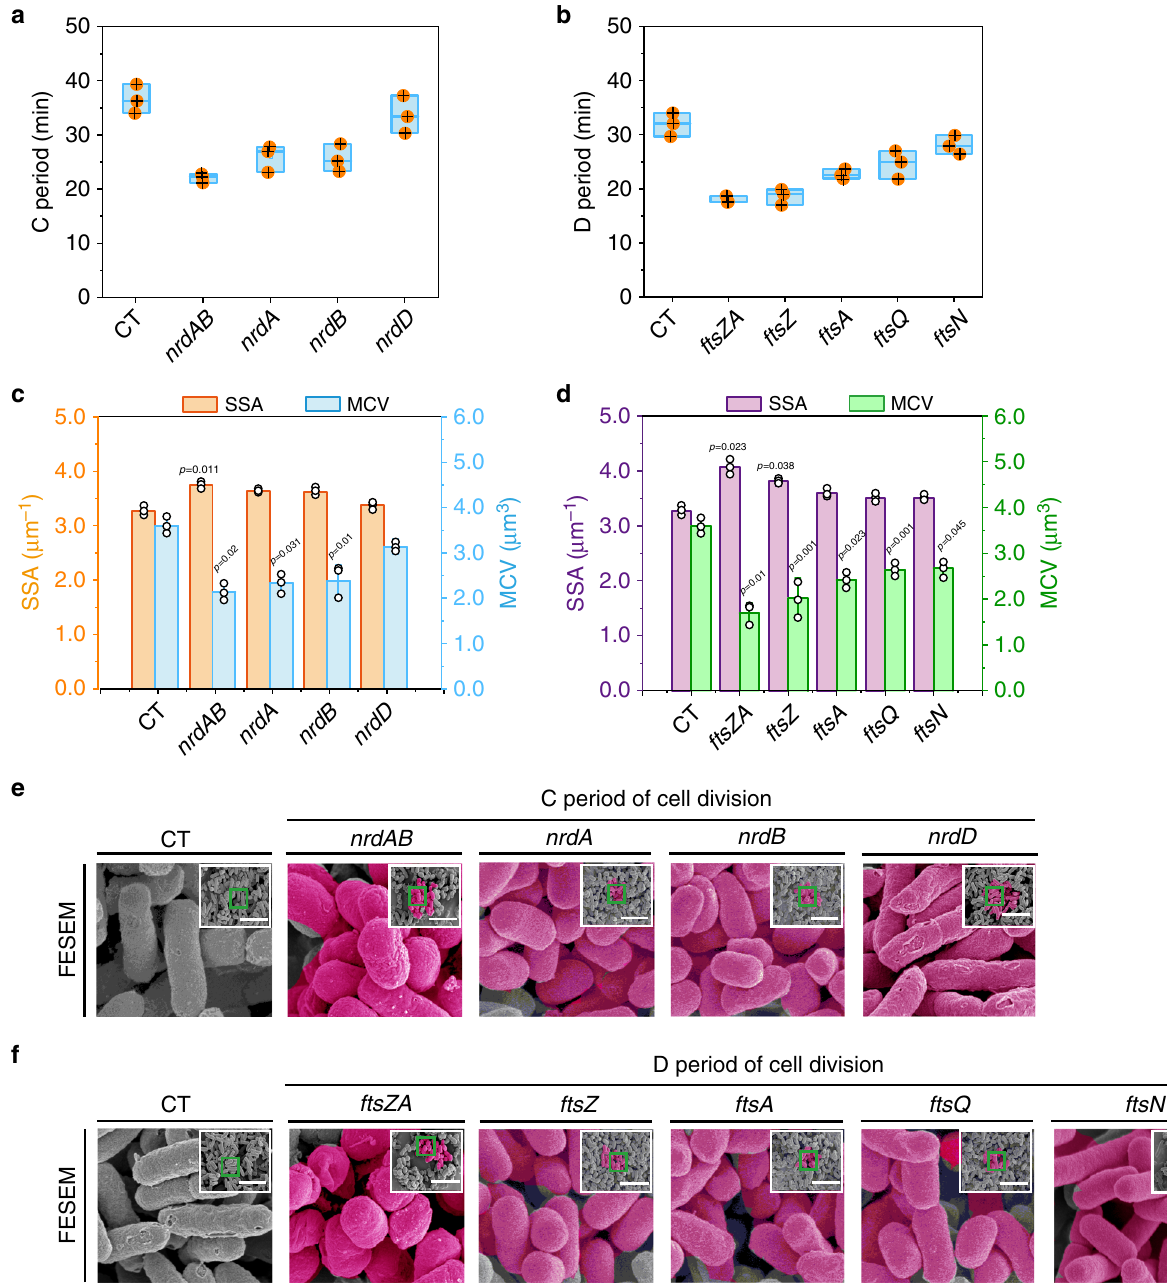
Fig. 1 Shortening the C and D periods of cell division by genetic manipulation. a , b Effect of shortening the C and D periods of cell division on cell division. c , d Effect of shortening the C and D periods of cell division on the speci fi c surface area (SSA) and mean cell volume (MCV), respectively. e , f Con fi rming the morphological variations of all engineered strains by the fi led emission scanning electron microscopy (FESEM). The pink color of FESEM was highlighted. The original pictures were shrinked into the top right corner of the enlarged pictures. a , b The box plots de fi ne the minima, maxima, center, and bounds of box. e , f The scale bar is 5 μ m. Signi fi cance ( p -value) was evaluated by two-sided t -test compared to CT. a – d Values were shown as mean ± s.d. from three ( n = 3) biological independent replicates. Information for each gene was provided in Supplementary Note 1. Source data are provided as a Source data fi